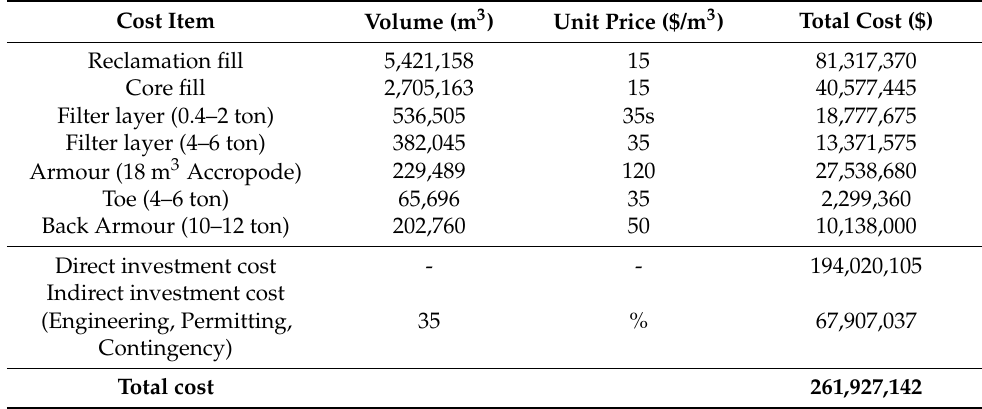
Table A2. Cost estimate for the artificial island: Alternative No.